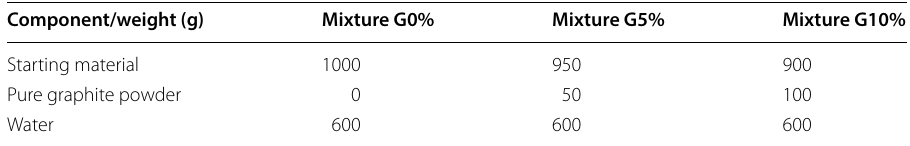
Table 1 Components used for the preparation of the bentonitic grout mixtures with various proportions of pure graphite powder as additive (G0% no graphite powder; G5% mixture with 5% of graphite; G10% mixture with 10% of graphite)